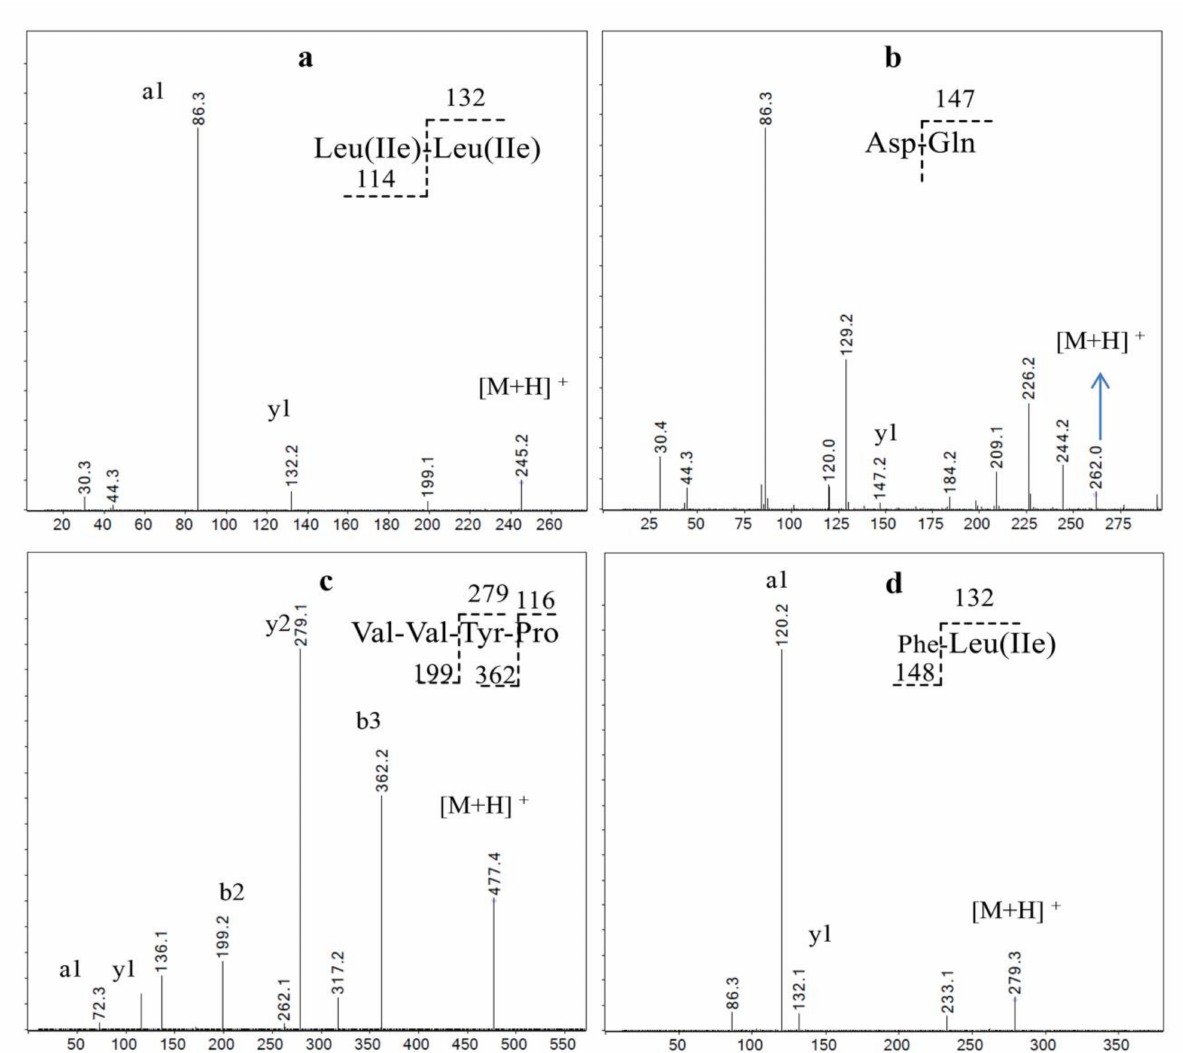
Figure 5. MS/MS spectra analysis of the main peptides in Fr4, ( a ) Leu(Ile)-Leu(Ile), ( b ) Asp-Gln, ( c ) Val-Val-Tyr-Pro, ( d )